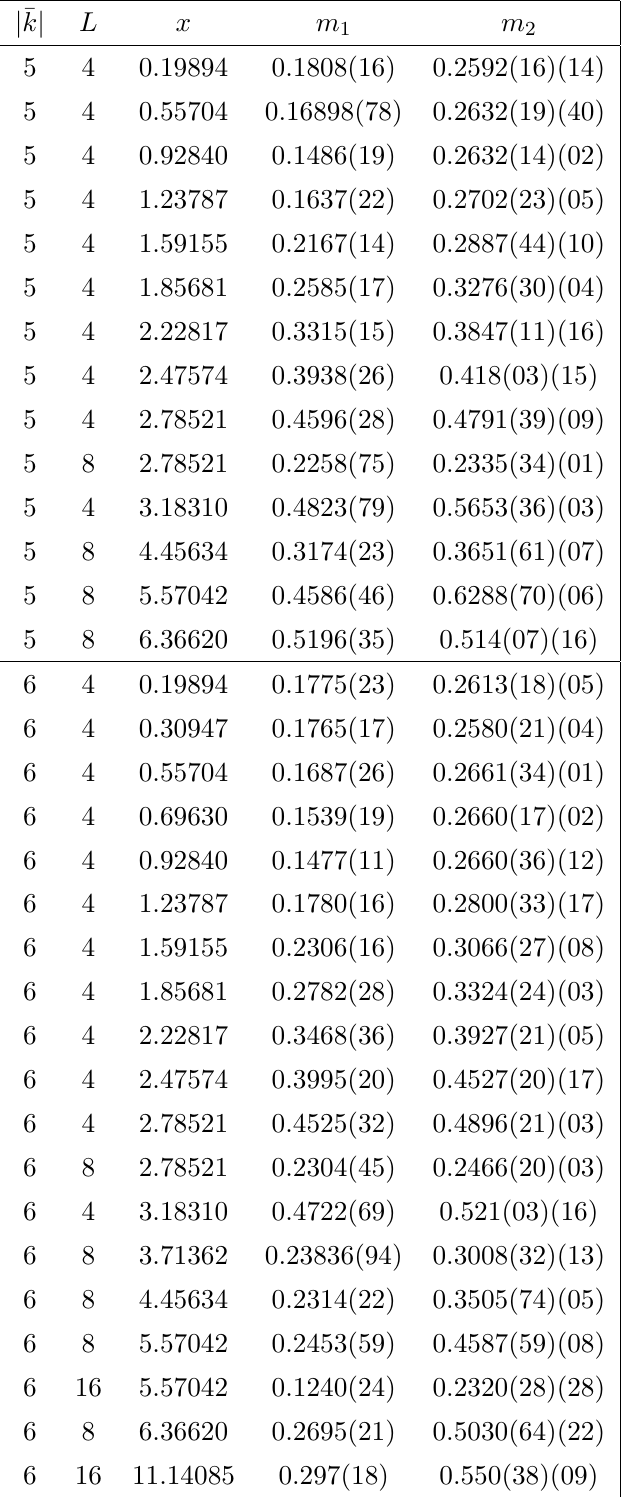
Table 27. Mass gap and next excited state energy (in lattice units) in the zero-electric (cid:13)ux scalar sector for SU(17)